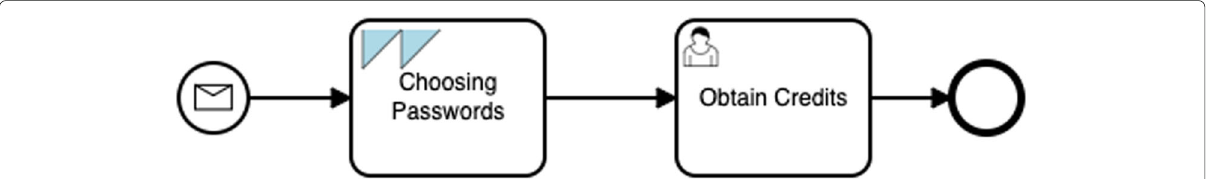
Fig. 7 Micro-learning process can be triggered by a process managing password